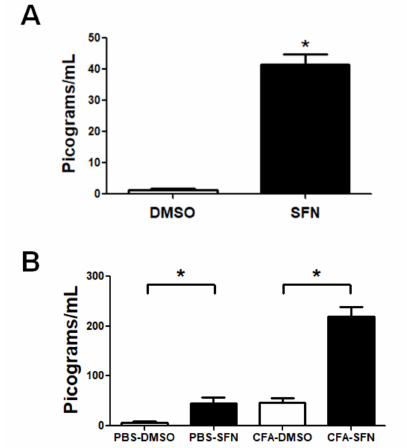
Figure 5. Circulating and synovial fluid levels of IL-6 in mice with mono-arthritis. Plasma ( A ) and synovial fluid ( B ) concentrations of IL-6 in samples obtained from vehicle- (open bars) and SFN- (closed bars) treated mice. Data are mean ± SEM. Experiments were performed in four different occasions ( n = 14 animals per group). * p <